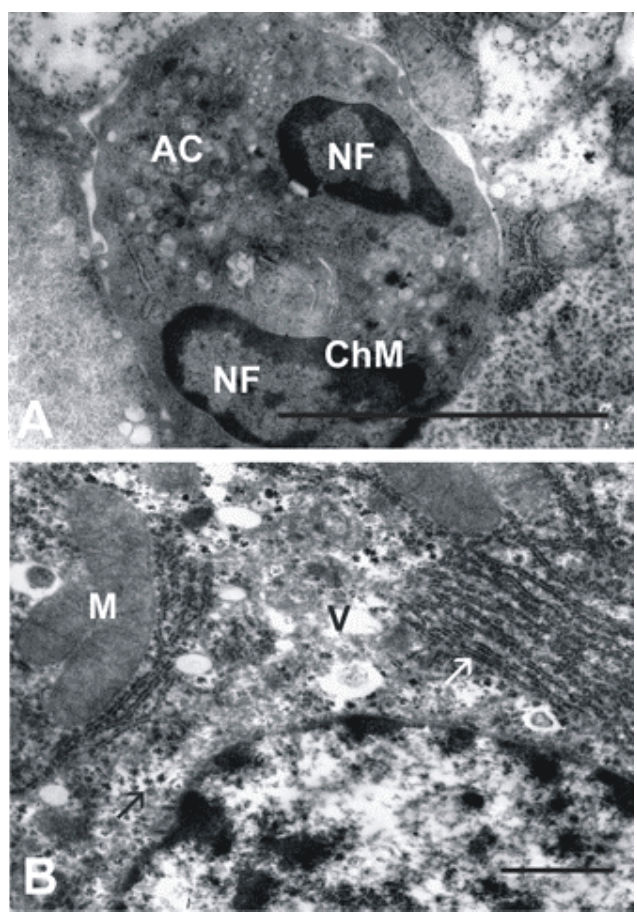
FIGURE 4. Apoptotic hepatoblast and ultrastructural changes of hepatocytes of young rats at the early stage of apoptosis. (A) First discrete stage of apoptosis; nuclear fragments (NF) with marginated chromatin (ChM). ED19. (B) Agglutination of ribosomes on cisterns of residual RER (white arrow), dark large mitochondria (M), vacuoles (V), granules of glycogen (black arrow). One hour after injection of cycloheximide. (C) Vacuoles, small dark mitochondria, reduced RER, and round intact nucleus with small nucleolus (Ni) in apoptotic cell (AC) at the early stage of apoptosis. One hour after injection of antibiotic. (D) Apoptotic hepatocyte containing small vesicles, polymorphic mitochondria, and dark inclusions. Two hours after injection of cycloheximide. (E) Excrescence (Ex) of apoptotic hepatocyte penetrating into necrotic cell (NC); cisterns of RER are presented as elongated and flat bars surrounding mitochondria (arrow); nucleus with primary feature of chromatin margination not containing nucleolus. Two hours after injection of cycloheximide. (F) Apoptotic hepatocyte, the cytoplasm of which is transformed into large excrescence (arrowheads) and contains compact mitochondria; nucleolus absent. Three hours after injection. Scale bars A, C– F, 5 μ m; B, 1 μ